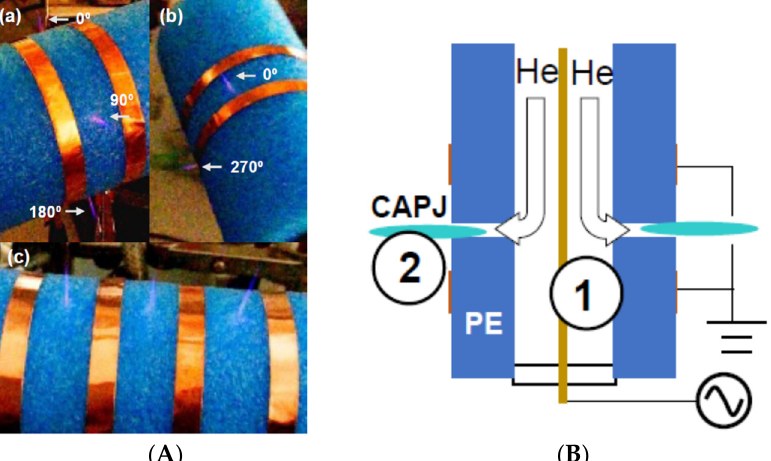
Figure 9. ( A ) Images of the APPJ radial source in operation. Plasma jets are ignited from arrays either around the perimeter ( a , b ) or along the axial direction of the polyethylene (PE) cylinder ( c ). The cylinder has an outer diameter of 5.4 cm. ( B ) Scheme of the active DBD region (1) and the afterglow region (2) with the He cold atmospheric plasma jets (CAPJs). Reprinted/adapted with permission from Ref. [47]. Copyright 2021, Authors.